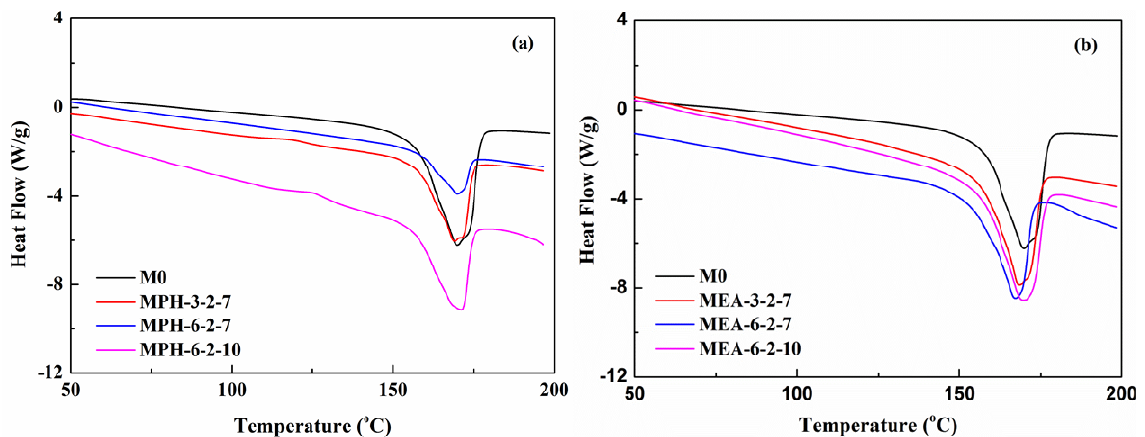
Figure 4. DSC curves of various membranes ( a ) polyMPDSAH-g-PVDF membrane; ( b ) polyMEDSA-g-PVDF